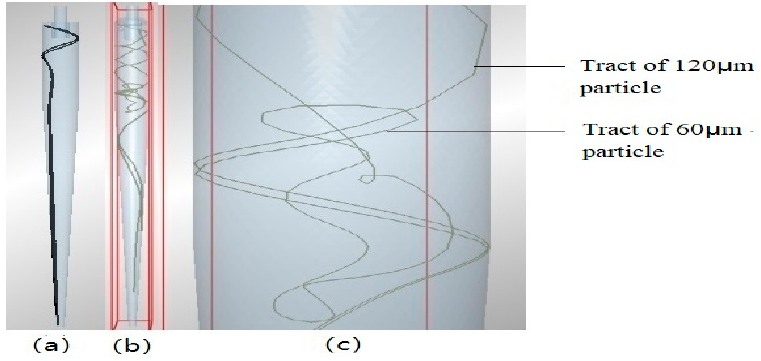
Figure 10. Representative motion tracks of particles.